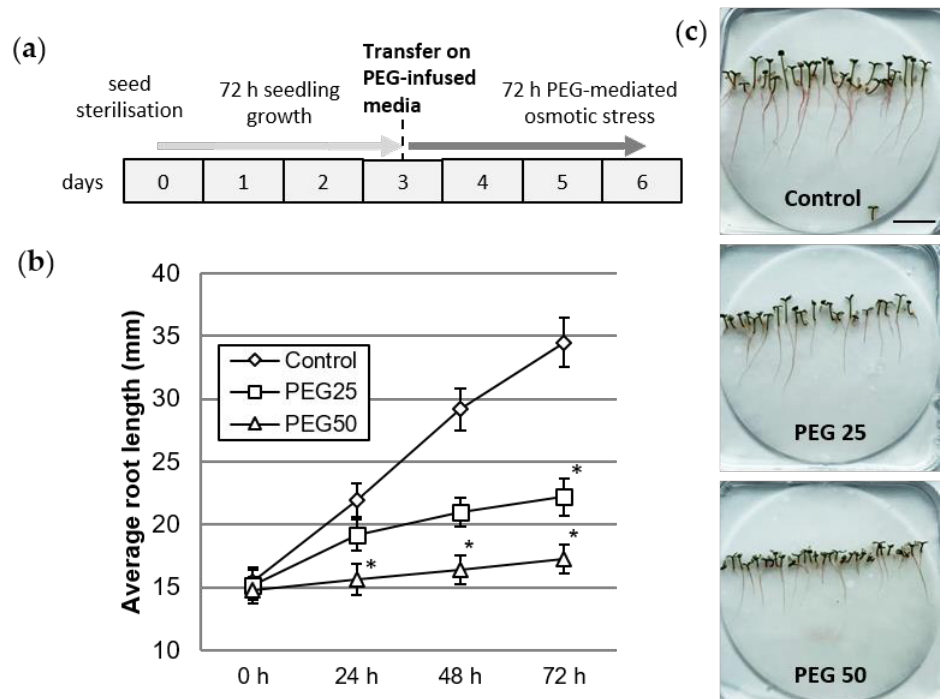
Figure 1. Plant growth under control and osmotic stress conditions. ( a ) Schedule of seedling culture and osmotic stress application. ( b ) Root growth kinetics of seedlings grown for 72 h under control and PEG-mediated osmotic stress conditions. Mean and standard error from six biological replicates (10 plants per replicate). * indicates significant difference with the control at level alpha = 0.05 according to Kruskal–Wallis test with Dunn’s procedure. ( c ) Six day-old seedlings after 72 h growth under control, moderate (PEG25), or strong (PEG50) osmotic stress conditions (bar scale: 2 cm).